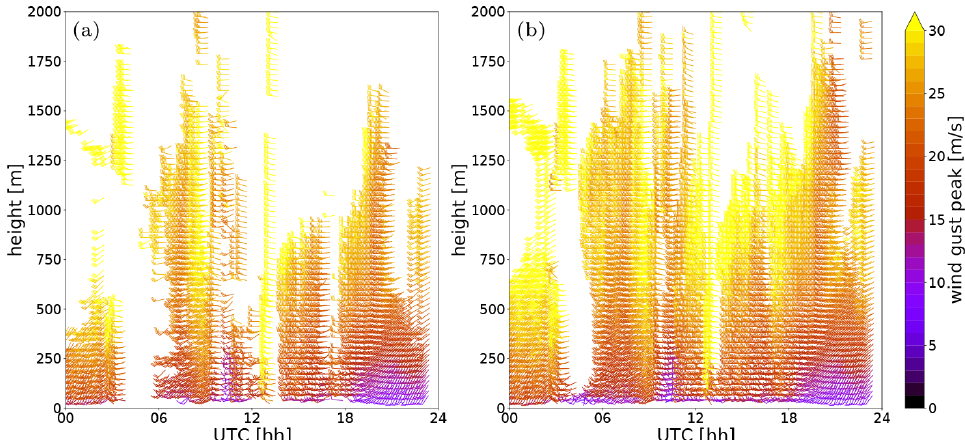
Figure 10. Color-coded wind barbs for gust peaks during extratropical cyclone Sabine on 10 February 2020 from the DWL operated in CSM2. (a) Results for a retrieval with classic SNR filtering at − 18 . 2dB and MLE. (b) Results without SNR filtering and iteratively improved MLE as developed in this study. In both approaches, the gust peak per 10min is only given if at least 50% of the DWL cycles obtain valid